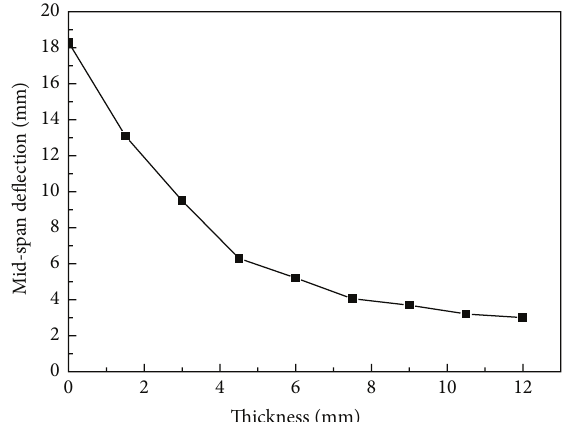
Figure 19: Effect of thickness of steel facesheet on mid-span deflection.